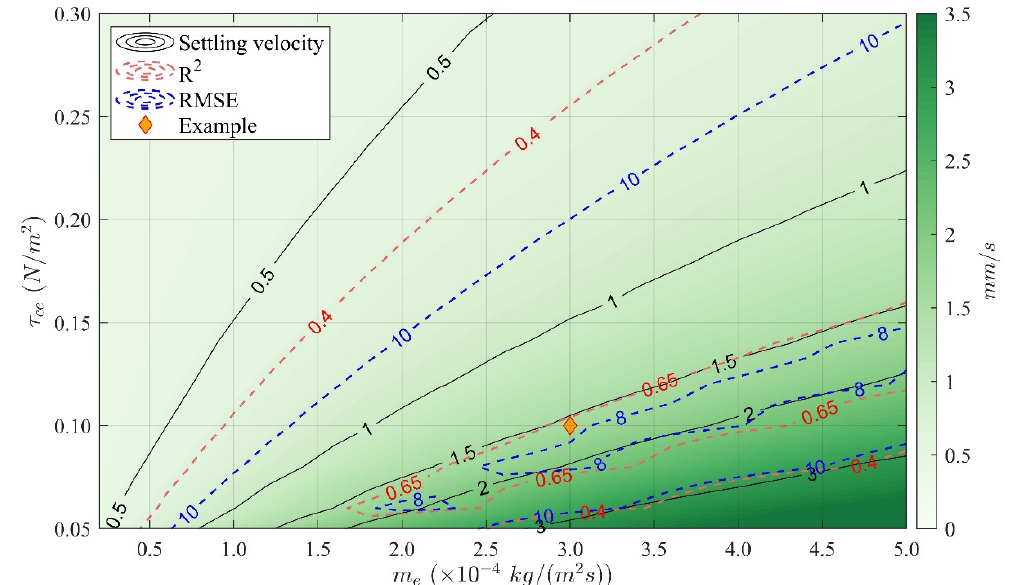
Figure 6. Average value of fitted 𝑤 (cid:3046) , (cid:2868) (black contours) as a function of 𝜏 (cid:3030)(cid:3032) and 𝑚 (cid:3032) . The red and blue dashed lines indicate contours of averaged 𝑅 (cid:2870) and RMSE ( 𝑅 (cid:2870) and RMSE are time ‐ varying in the running window fitting). The diamond ‐ shape marker denotes an example of parameterized 𝜏 (cid:3030)(cid:3032) , 𝑚 (cid:3032) , and 𝑤 (cid:3046) , (cid:2868) (1.6 mm/s). Figure 7 exemplifies time series of the data fitting for the parameter settings corre ‐ sponding to the diamond ‐ shape mark in Figure 6 ( 𝑚 (cid:3032) = 3 (cid:3400) 10 (cid:2879)(cid:2872) kg (cid:4666) m (cid:2870) s (cid:4667) ⁄ , 𝜏 (cid:3030)(cid:3032) = 0.1 N m (cid:2870) ⁄